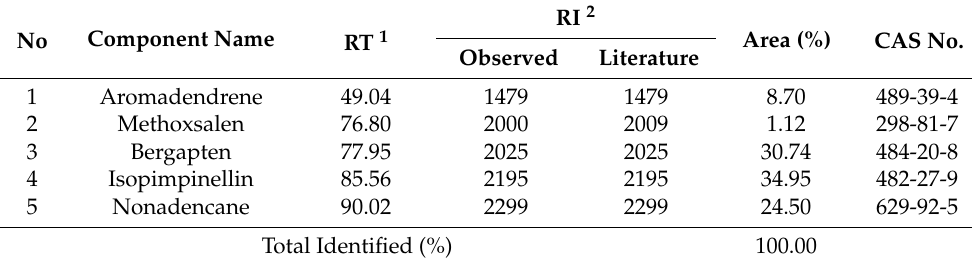
Figure 6. GC/MS total ion chromatogram of Angelica polymorpha Maxim. flower absolute. Peak numbers indicate compound numbers (bracketed); retention times (below bracketed numbers) of the 5 identified compounds are listed in Table 1. The chemical structures of the 5 compounds are shown on the right of the chromatogram. Table 1. Chemical compounds identified in the GC/MS assay of Angelica polymorpha Maxim. flower